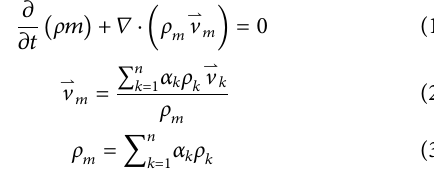
Frontiers in Energy Research |